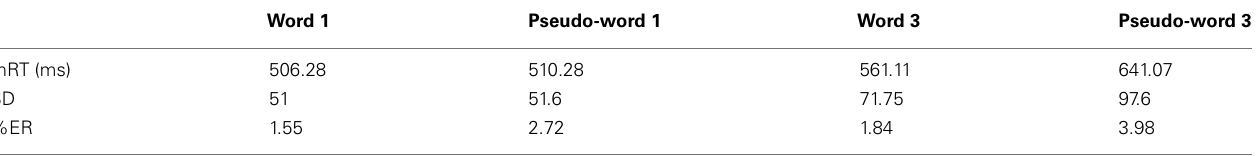
The table resumes the mean reaction time (mRT), the SD and the mean error rate (% ER) for verbal items according to lexicality (words, pseudo-words), and length (one-syllable,